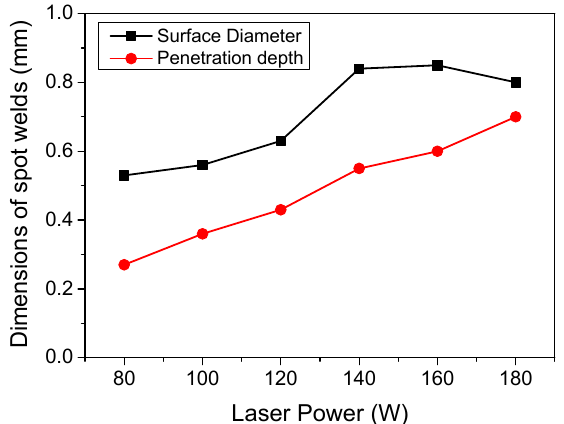
Figure 4. Dimensions of spot welds fabricated with different laser powers (weld time: 0.05 s, defocusing distance: +1 mm).